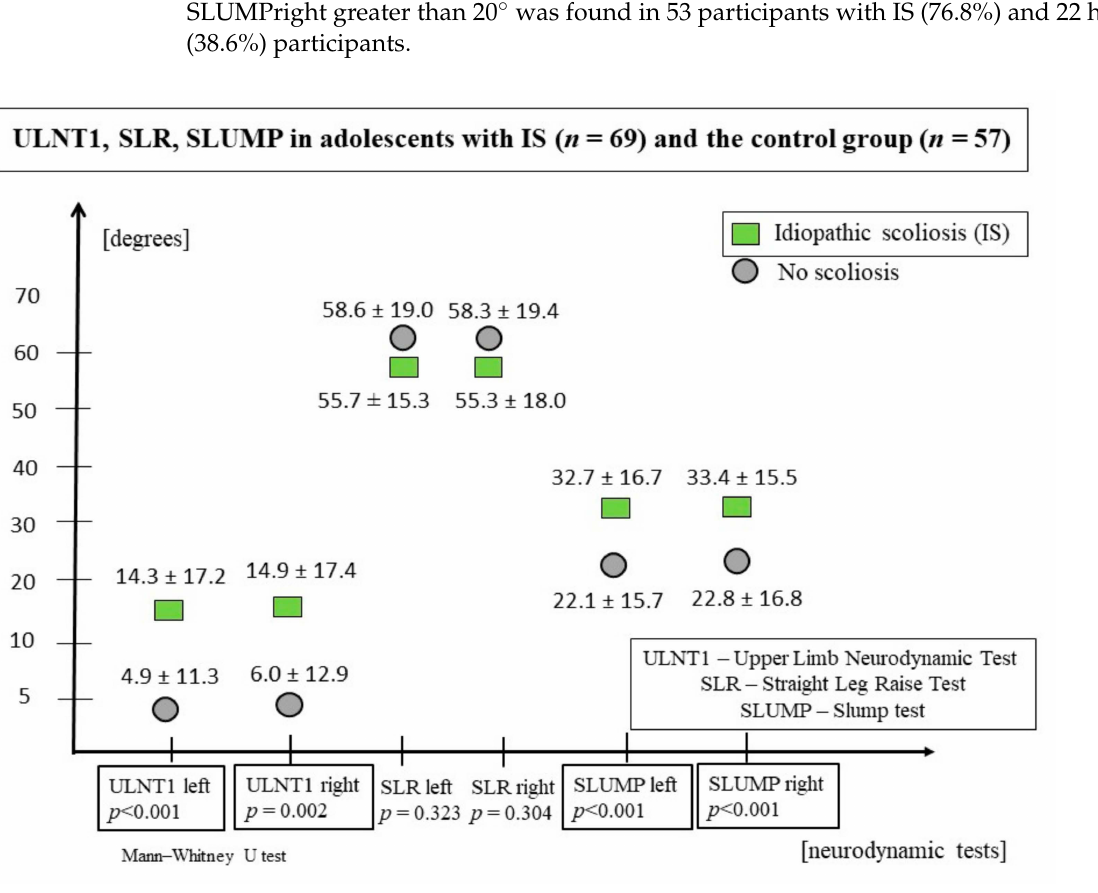
Figure 3. ULNT1, SLR and SLUMP values in adolescents with IS and in the control